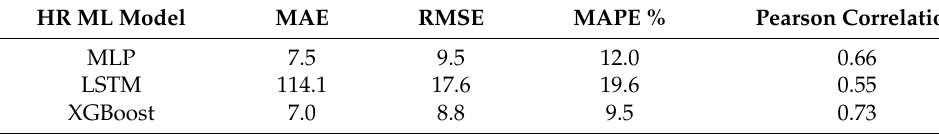
Table 4. Testing Performance Results of the HR ML Models.